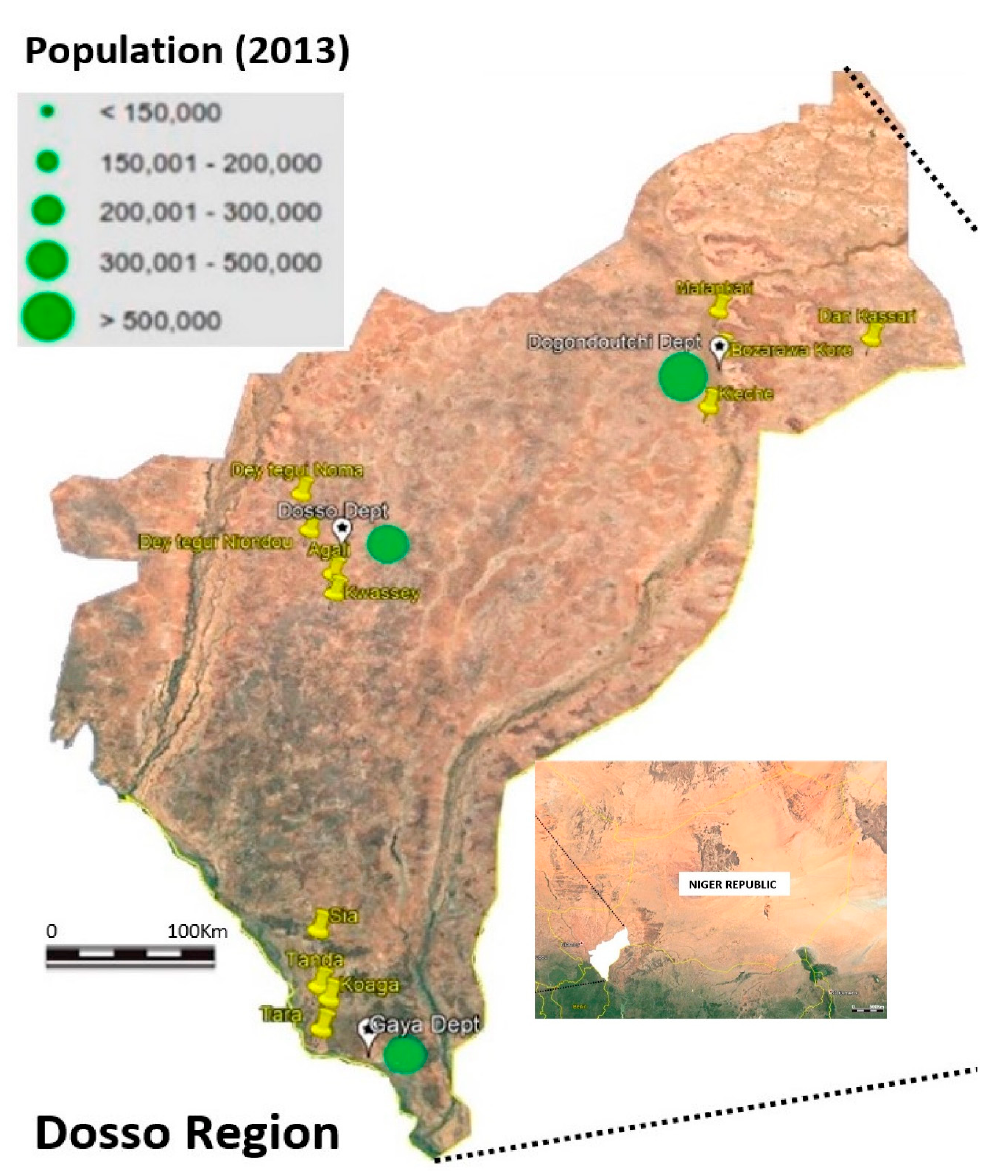
Figure 1. Departments of the Dosso region in Niger, in yellow are the villages where a participatory rural appraisal (PRA) was conducted, Black pentagram represents the departments where the study was conucted (modified from Google Earth 2018).